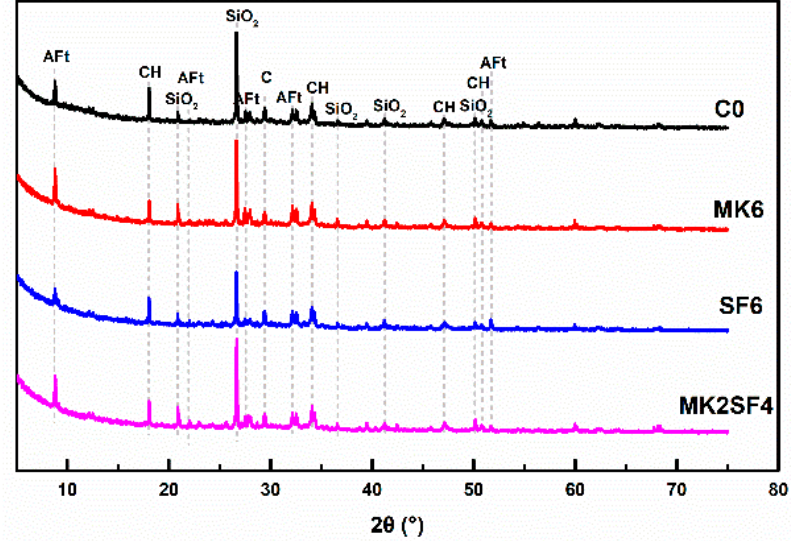
Figure 10. XRD patterns of specimens after curing for 28 days.